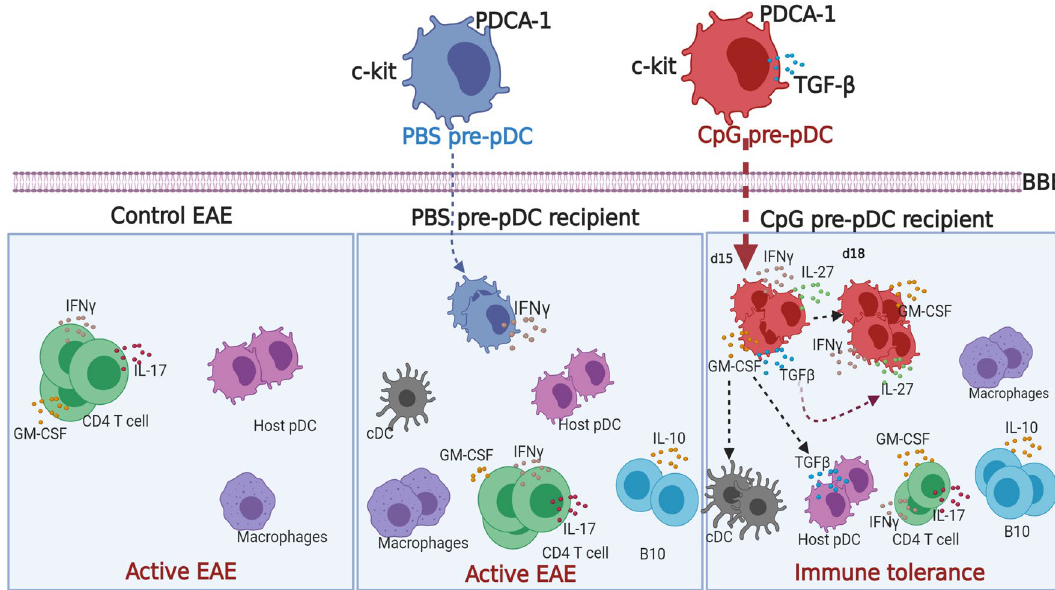
released only by CpG-pre-pDCs in the first 3 days in the spinal cord (light blue zone) of mice protects against EAE by prompting host pDCs to release in turn TGF-β and promoting accumulation of CD11c + CD11b + cDCs and IL-10 + B cells. CpG-pre-pDCs, once migrated to the spinal cord, additionally release IL-27 that from